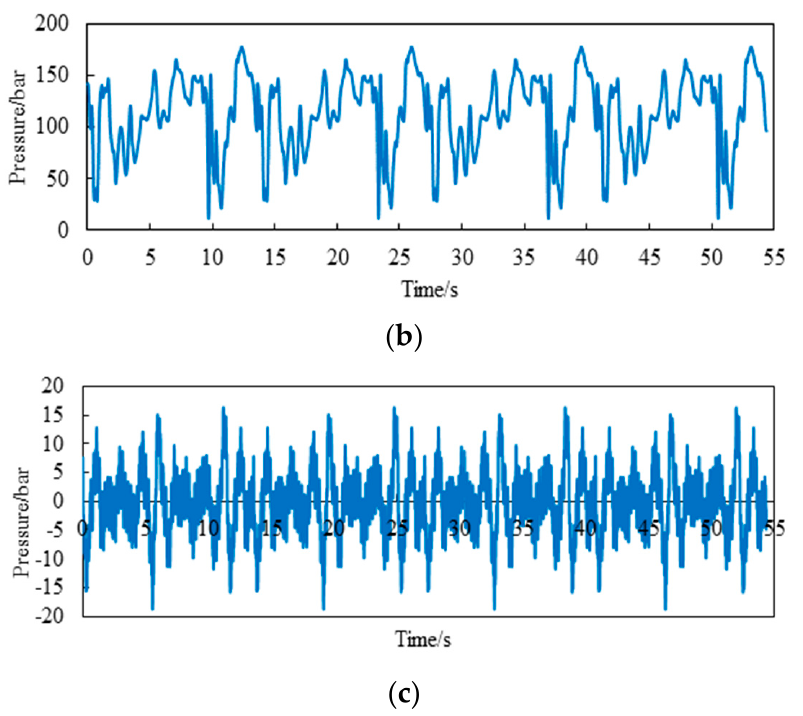
Figure 14. Wavelet decomposition results of main pump 2 in operation condition. ( a ) Original data; ( b ) trend term data; ( c ) random term data. Table 3. Rounds statistics of load random